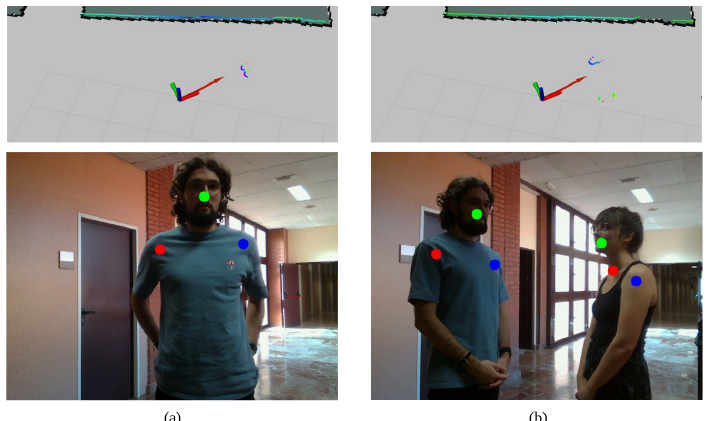
Figure 24. People detection: ( a ) a person approaches the robot, so its feet are detected by the 2D LiDAR ( top , where the red arrow is the robot position and green/blue zones are 2D LiDAR data) and its shoulders and nose are detected by the RGBD camera ( bottom , where the red dot is the right shoulder, green is the nose and blue is the left shoulder), ( b ) a group is formed, so two sets of feet ( top ) and two torsos ( bottom ) are